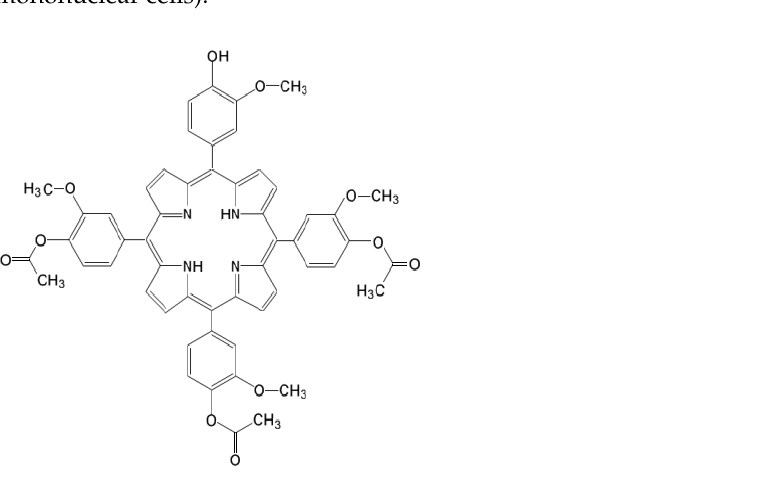
Figure 1. Chemical structure of 5-(4-hydroxy-3-methoxyphenyl)-10, 15, 20-tris-(4-acetoxy-3- methoxyphenyl) porphyrin (P2.2).